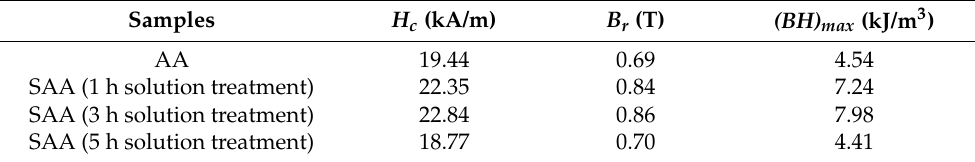
Figure 9. Bright-field image of the Fe-25Cr-15Co alloy with SAA (1 h solution treatment); ( a ) at lower magnification and ( b ) at higher magnification. 3.3. M e chanical Behavior The mechanical properties of Fe-25Cr-15Co samples were also investigated. When the spinodal decomposition of Fe-25Cr-15Co occurs, component fluctuations produce two